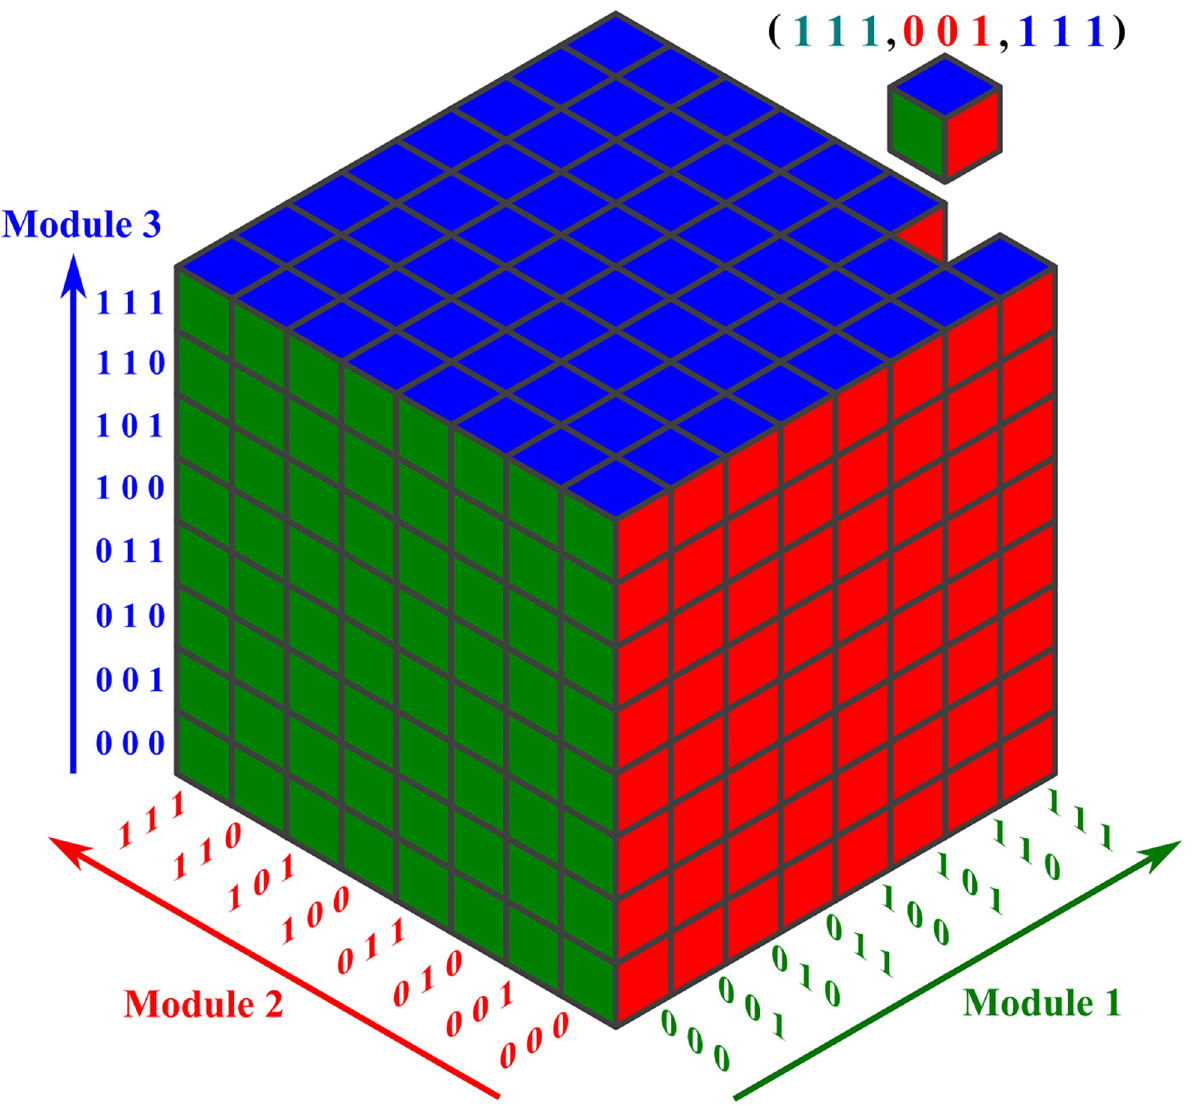
Fig 2. The orthotope for the network structure of Fig 1. The dimension of the orthotope is equal to the number of first-layer black-box modules of the tree-structured hybrid network of Fig 1. Each cell of the orthotope, characterized by three coordinates, represents an input data point holding the corresponding output label. Each intersection of a hyperplane with the orthotope holds input data with a constant input for a specific first-layer black- box module. For example, the uppermost horizontal blue slice of the orthotope illustrates all input vectors whose last three entries are 1, 1, 1.